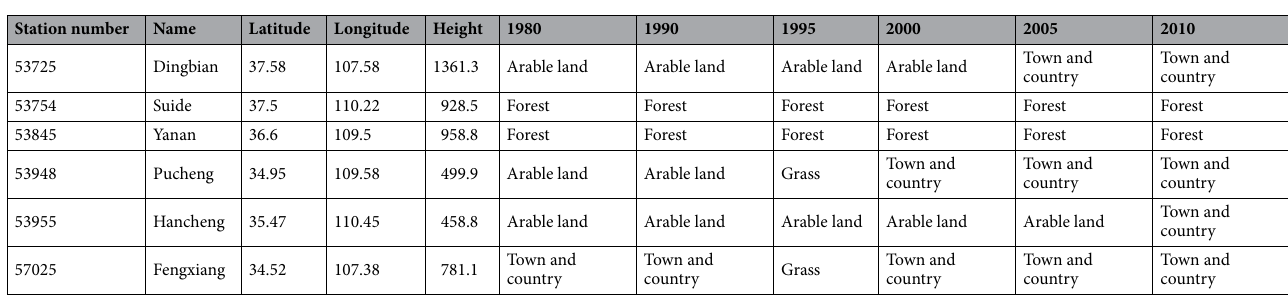
Table 1. Information of